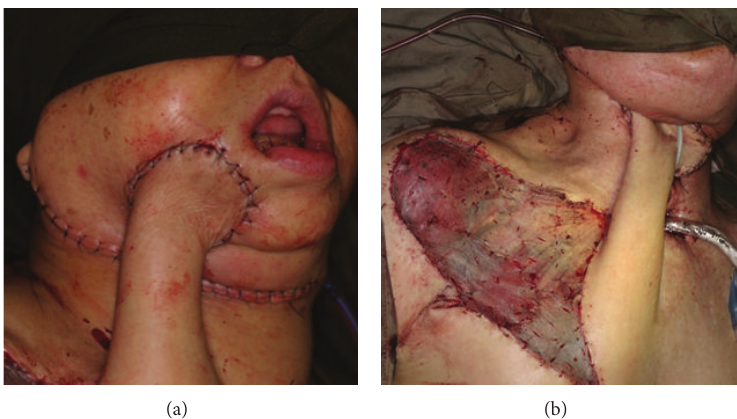
Figure 1: (a) Tubed DP flap for reconstruction of facial skin defect. (b) Tubed DP flap for reconstruction of neck skin defect. DP can be divided two weeks after initial surgery under local anaesthesia for both cases.